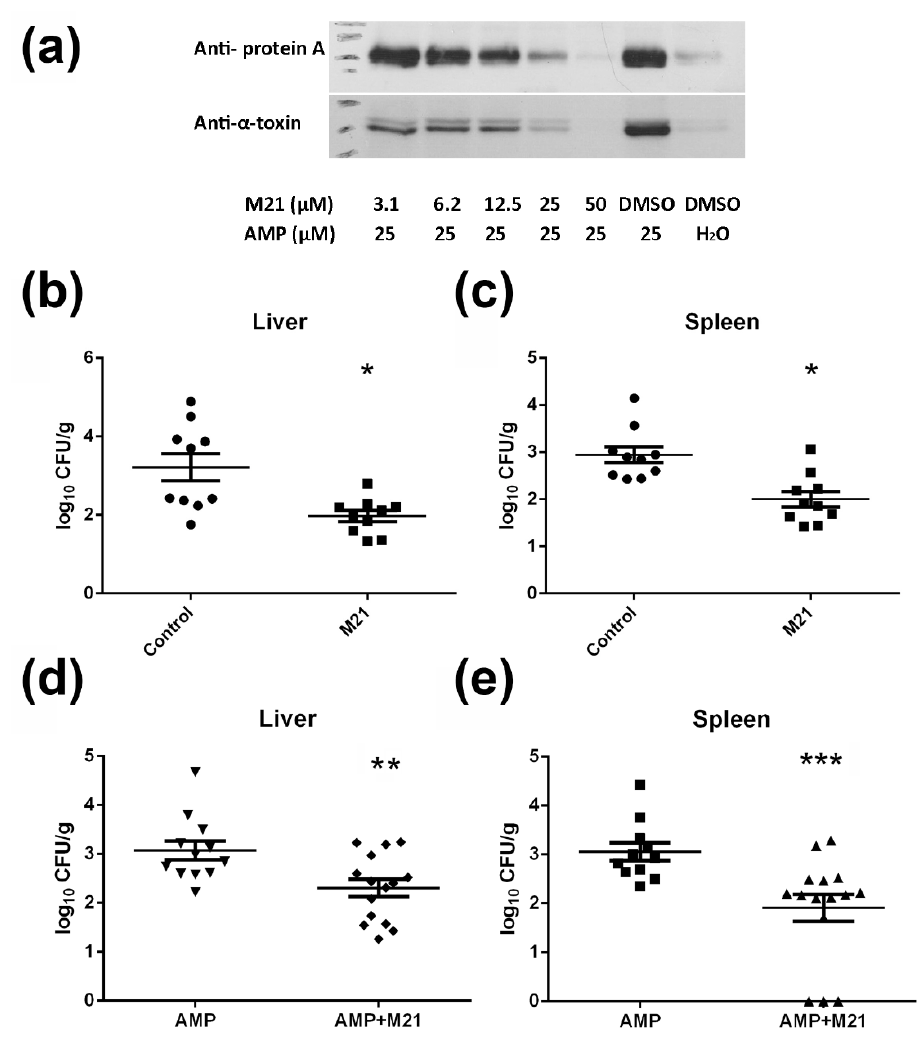
Figure 2. Compound M21 suppress the production of virulence factors induced by ampicillin and reduces S. aureus pathogenicity in vivo. ( a ) Ampicillin-induced production of protein A and α -toxin was suppressed by different concentrations of compound M21. ( b , c ) M21 treatment reduced bacterial loads in mice, liver ( b ), and spleen ( c ). ( d , e ) M21 in combination with ampicillin treatment, reduced bacterial loads in mice, liver ( d ), and spleen ( e ). Non-parametric tests (Mann–Whitney test) for treated groups, comparing with the vehicle group. Data represent mean values ± SEM (* p < 0.05; ** p < 0.01; *** p <0.001).